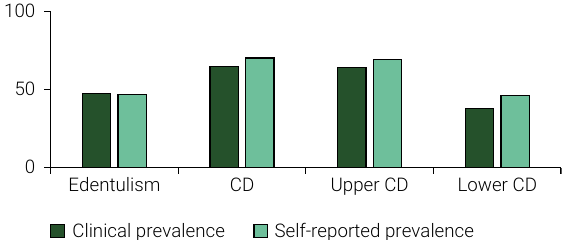
Figure 1. Prevalence of oral conditions. Estimates made by clinical examination and self-report are similar. CD, complete denture.